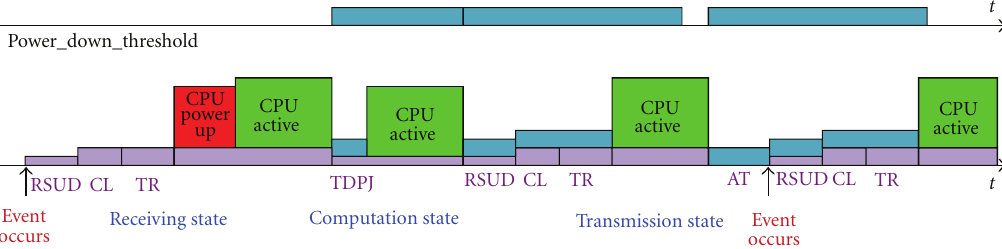
remaining always on as opposed to powering down